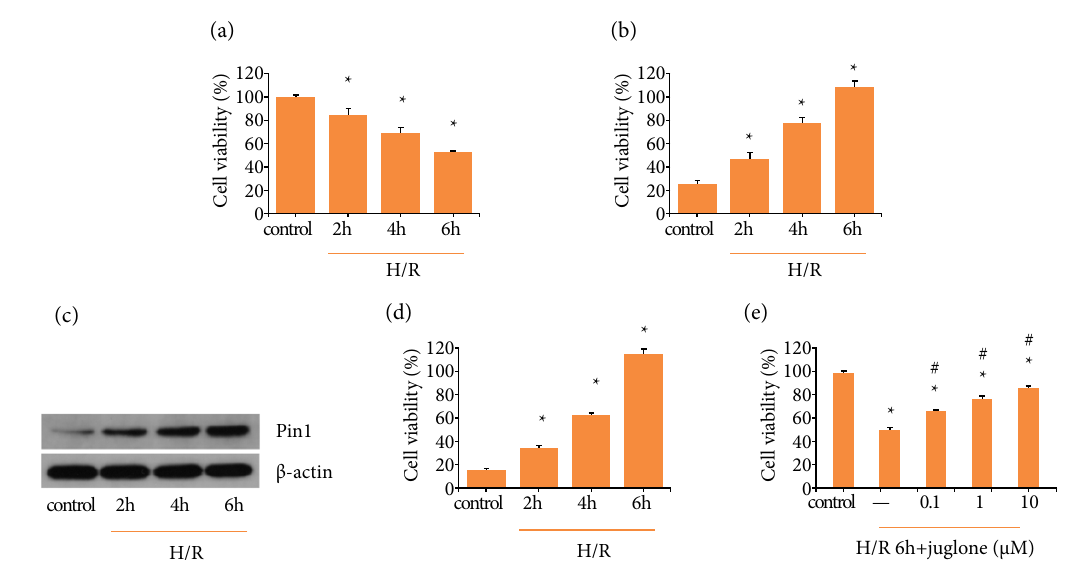
Figure 4 - Pin1 expression was elevated during H/R process in HK-2 cells and Pin1 inhibitor could protected cell ability against H/R. (a) Cell viability was detected at hypoxia 12 h and reoxygenation 2, 4 and 6 h, respectively. (b) Pin1 mRNA level was detected by RT-PCR after hypoxia 12 h and reoxygenation 2, 4 and 6 h, respectively. (c, d) Pin1 protein level was detected by western blot and the quantification was performed. (e) Cell viability was detected with the treatment of different concentration of Pin1 inhibitor at hypoxia 12 h and reoxygenation 6 h. Values were expressed as the mean ± SEM (n = 8). *P < 0.05, relative to control group; #P < 0.05, relative to H/R group.